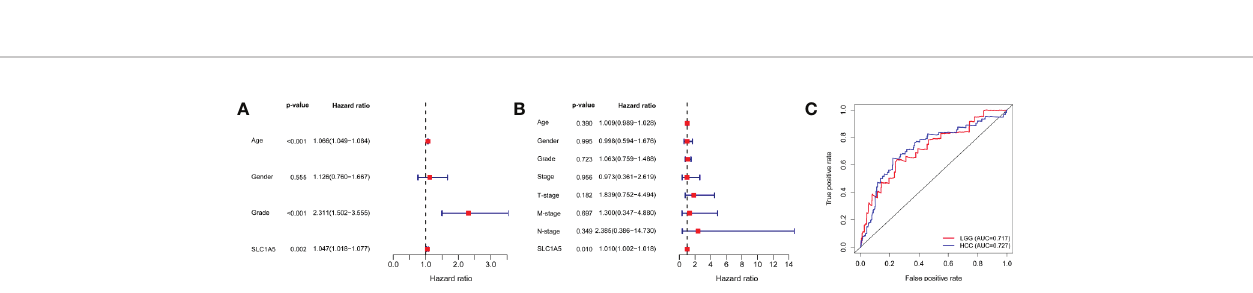
FIGURE 2 | Overall survival (OS) curves comparing high and low expression of SLC1A5 kidney clear-cell carcinoma (KIRC) (A) ; lower-grade glioma (LGG) (B) ; hepatocellular carcinoma (HCC) (C) ; mesothelioma (MESO) (D) ; stomach adenocarcinoma (STAD) (E) , and uveal melanoma (UVM) (F) in TCGA database.